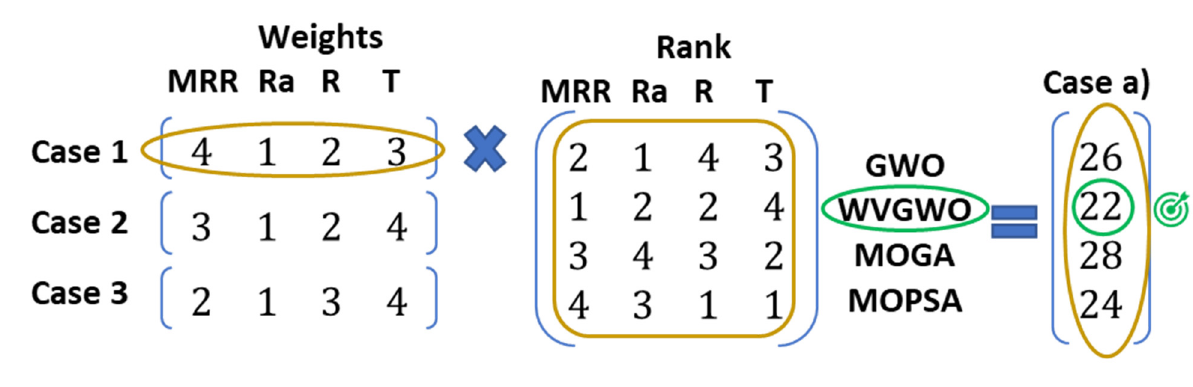
Table 7. Optimal solutions comparison of different used algorithms.